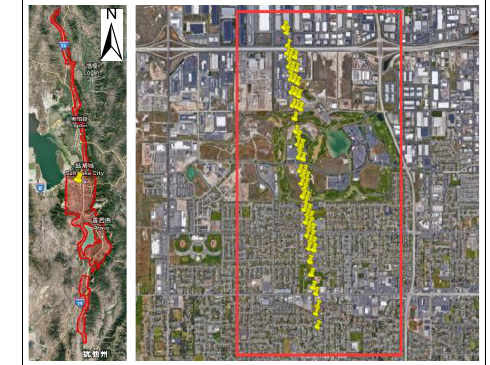
Figure 1. Study Area Overview